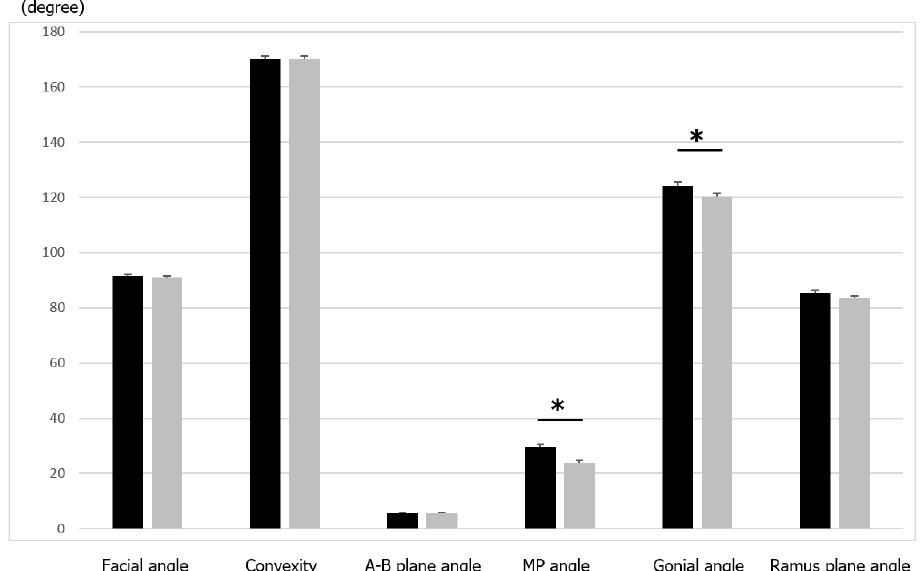
Figure 3. Comparison of skeletal variables between samurai and commoners. Values are presented as means ± standard deviations. The asterisks represent significant differences between the groups. Black, samurai group; grey, commoners. Table 3. Comparison of dentoalveolar variables between samurai and commoners. Variables (Degrees)